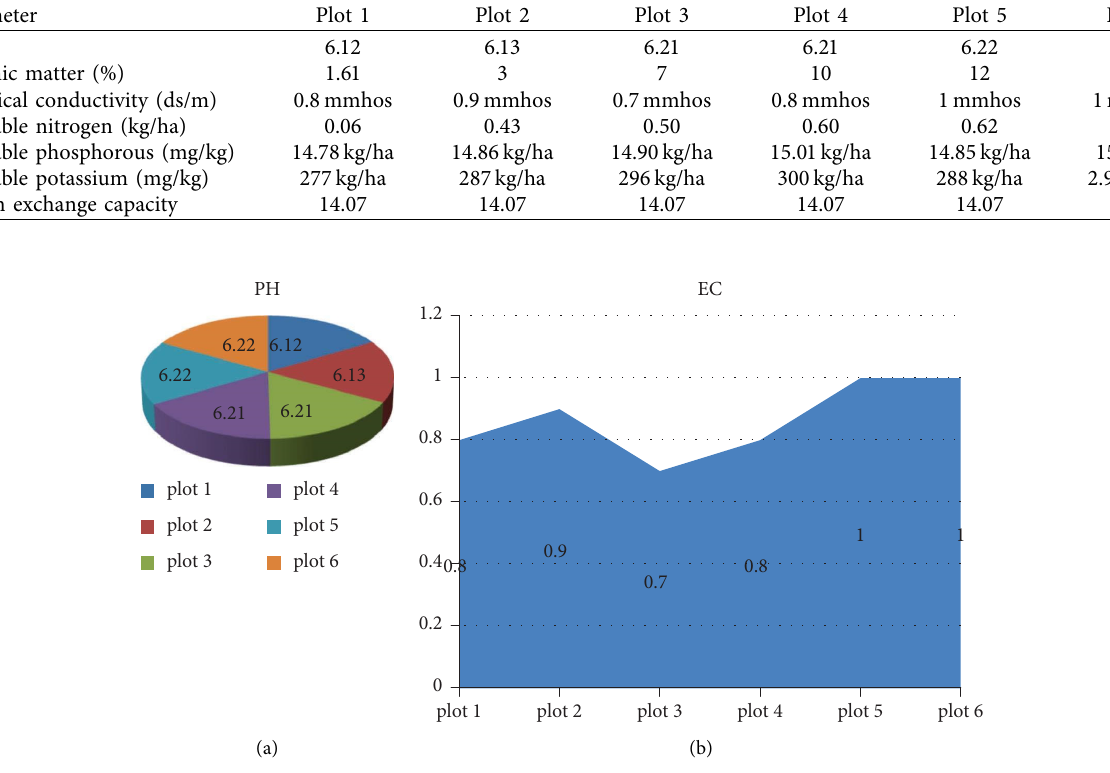
Table 3: Average laboratory mean of total nitrogen, organic matter, available potassium, available phosphorous, pH, and the cation exchange capacity of the sample wetland.